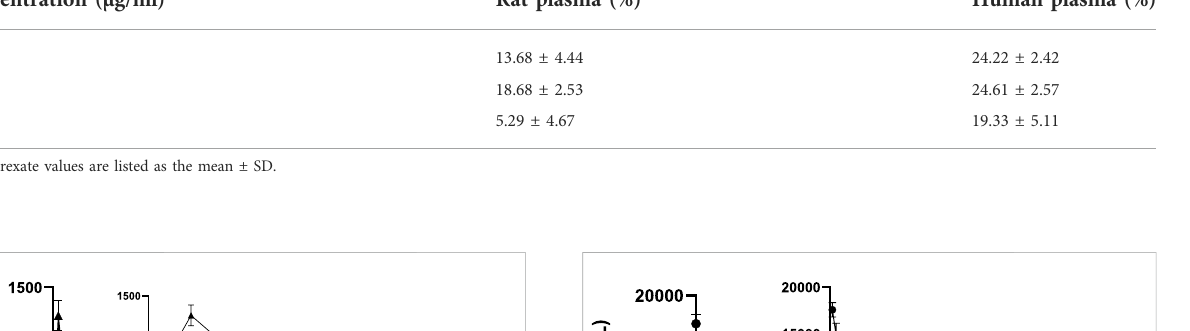
TABLE 5 Plasma protein binding rate of glytrexate in rat and human plasma (mean ± SD, n = 3). Concentration ( μ g/ml)